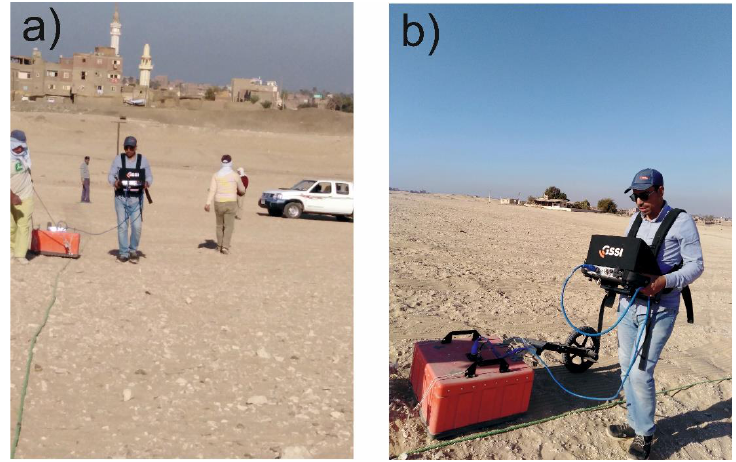
Figure 4. ( a ) is GPR field survey operation, and ( b ) is GSSI-SIR 4000 instrument attached with a central frequency antenna of 200 MHZ.